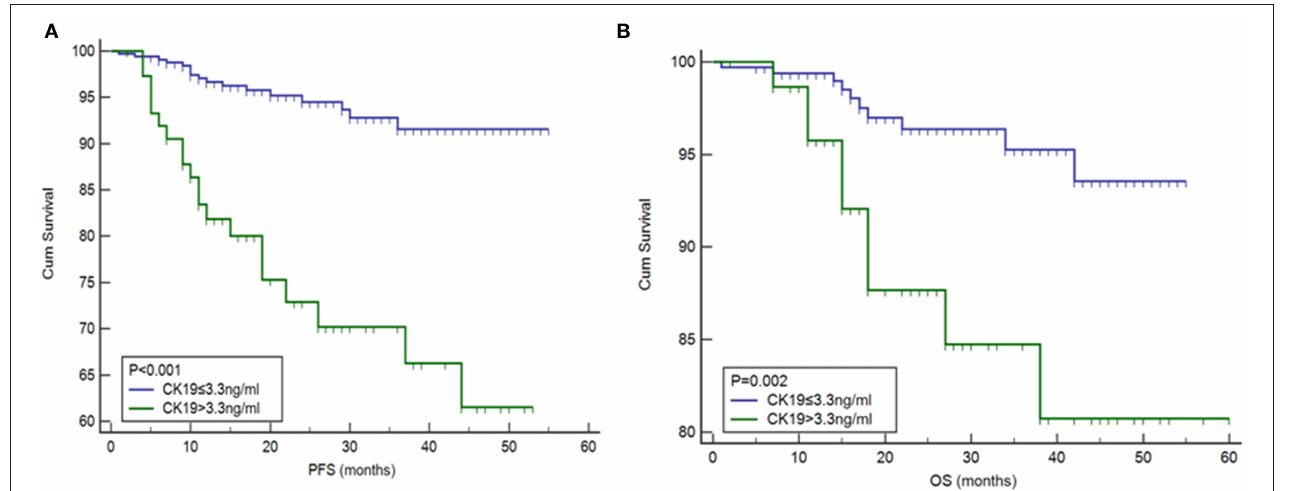
FIGURE 2 | Association between high levels of CK19 with (A) progression-free survival (PFS) and (B) overall survival